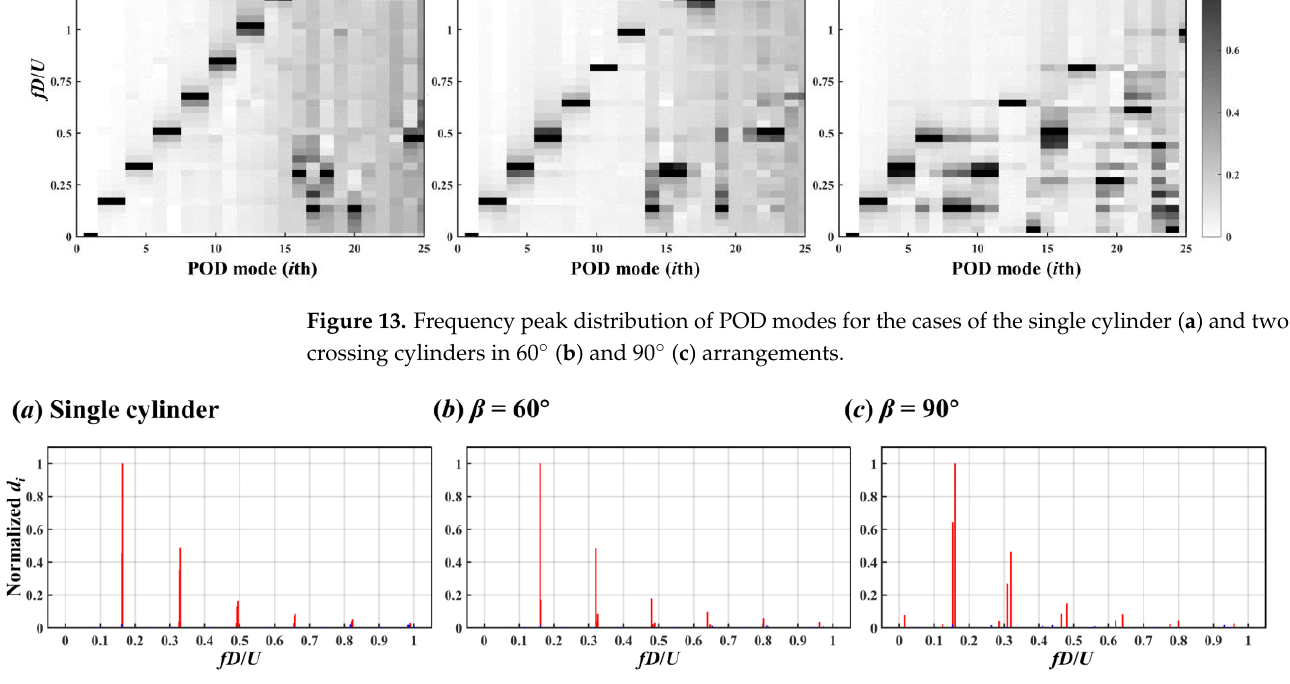
Figure 13. Frequency peak distribution of POD modes for the cases of the single cylinder ( a ) and